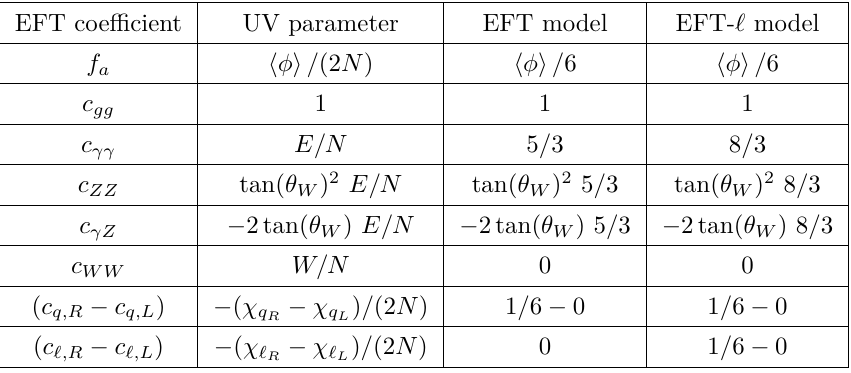
Table 1 . Summary of couplings of the model introduced in the present section, expressed in the EFT basis introduced in eqs. (2.1) and (2.3). The general dependence on the high-energy parameters is shown, together with the explicit value for each of the two variations of the model, the one with and the one without tree-level couplings to leptons. In the three cases c γγ , c γZ , and c ZZ , the coupling term should be written as in (4.20) with the electromagnetic fine structure constant α Further, the fermion coupling matrices in the last two rows are proportional to the unit matrix and 1 / 6 − 0 indicates that only right-handed fields couple at